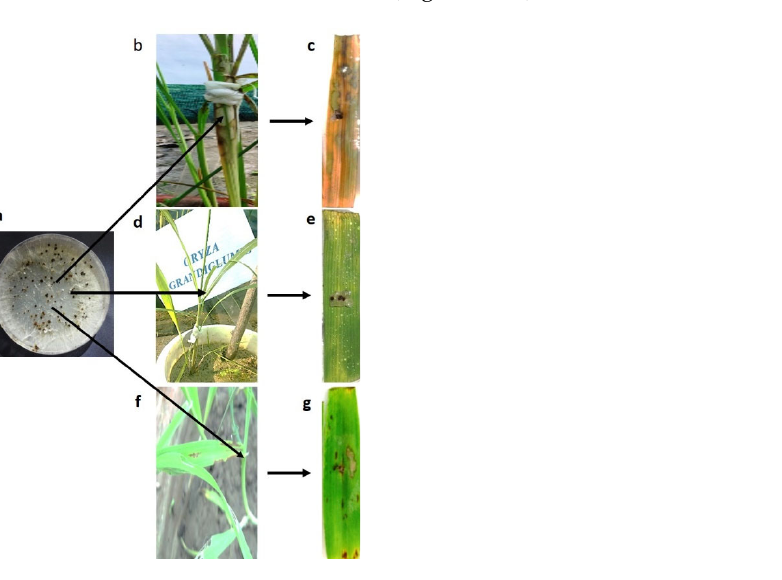
Figure 1. ( a ) R. solani (D ‐ 14 belonging to AG1 ‐ IA) isolate for the inoculation purpose to the hosts. ( b ) Disease reaction of R. solani on cultivated rice cv. Pusa Basmati ‐ 1. ( c ) Disease reaction of R. solani on cultivated rice cv. Pusa Basmati ‐ 1 by leaf detached method. ( d ) Disease reaction of R. solani on wild rice accession O. grandiglumis . ( e ) Disease reaction of R. solani on wild rice accession O. grandiglumis by leaf detached method. ( f ). Disease reaction of R. solani on barley cv. NDB ‐ 1445. ( g ) Disease reaction of R. solani on barley cv. NDB ‐ 1445 by leaf detached method.